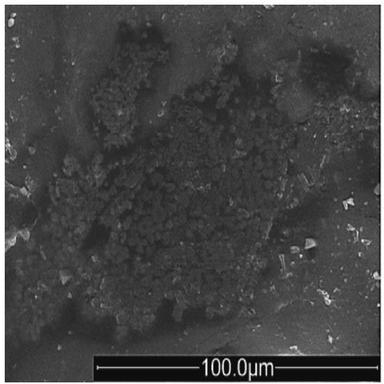
SEM observation of primary mullite crystals obtained after firing of Kaolinitic clay at 1200 C (Hitachi TM3000).